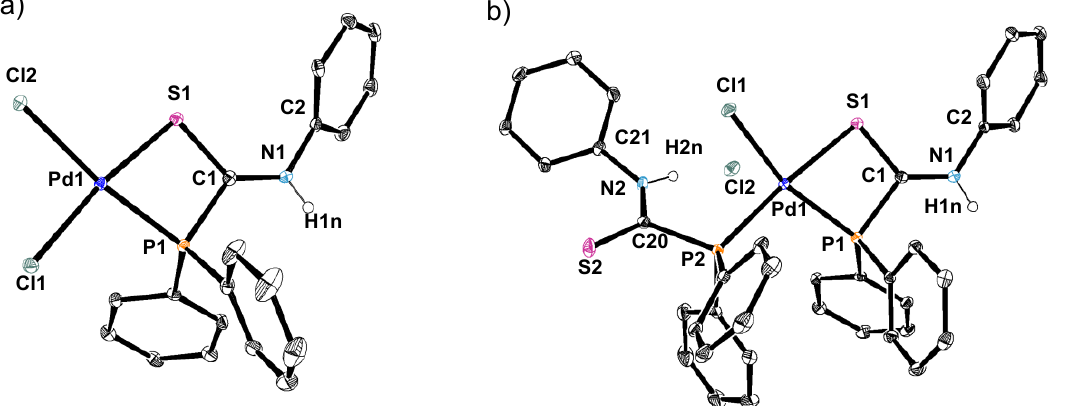
Figure 5. ORTEP drawings of ( a ) 4 · 0.5(CH 3 ) 2 CO and ( b ) cis- 5 · CH 2 Cl 2 with thermal ellipsoids at 30% probability. The crystal solvent and hydrogen atoms (except for NH protons) are omitted for simplicity. Selected bond lengths (Å) and angles ( ◦ ): Pd1–P1 2.2064(7), Pd1–S1 2.2954(8), Pd1–Cl1